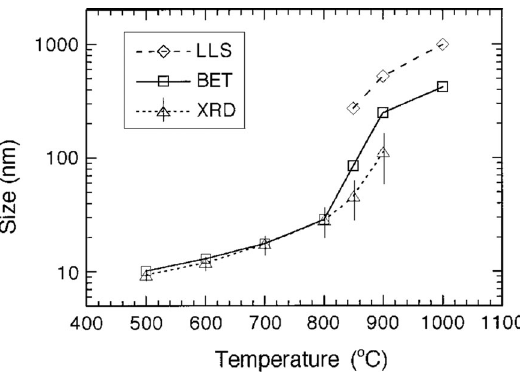
Fig. 3 Particle sizes of mechanochemically synthesised CeO 2 nanoparticles as a function of post-milling heat treatment temperature 70 . ( Δ ) Crystallite size estimated from the full-width at half maximum of X-ray diffraction (XRD) peaks, ( ⎕ ) particle size estimated from the Brunauer- – Emmett – Teller (BET) speci fi c surface area, and ( ◊ ) particle size measured using a laser-light scattering (LLS) method. Reproduced with permission from John Wiley and